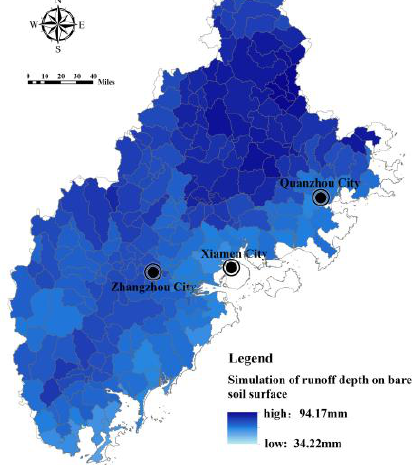
Figure 4. Drainage system distribution and sub-basin division in Fujian Delta.